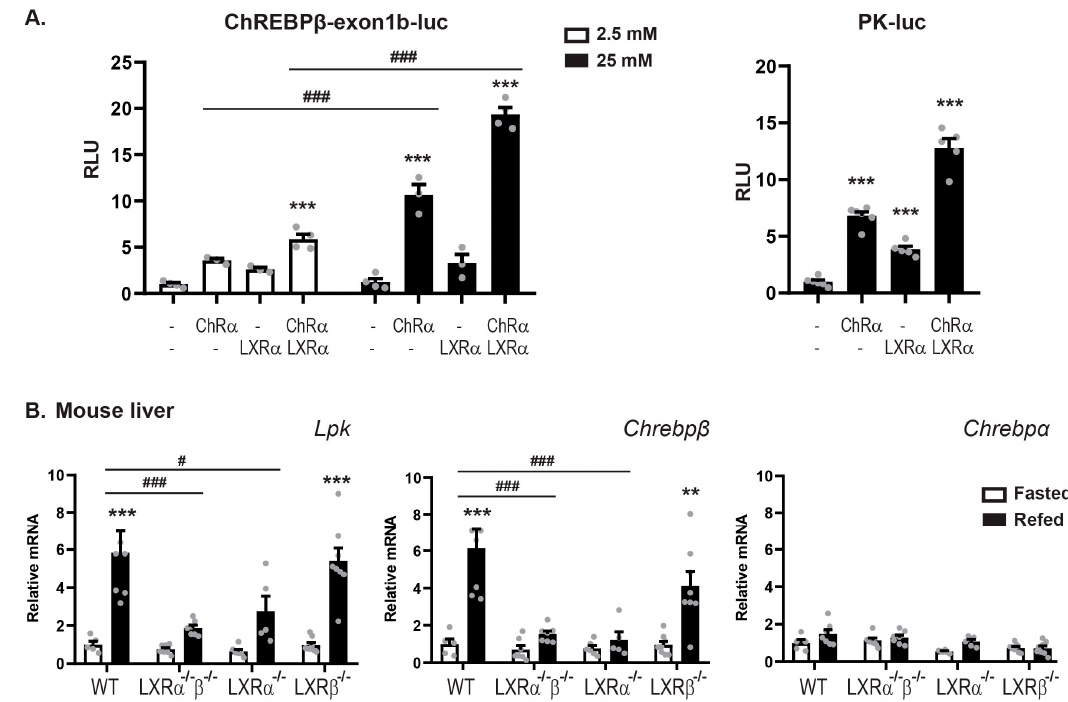
Figure 2. LXR α co-activates ChREBP specific target genes in vitro and in vivo . A. Huh7 cells cultured in 25 mM glucose were transfected with a Chrebp β ( n = 3) or Lpk -driven luciferase reporter ( n = 6) and plasmids expressing ChREBP α /Mlx γ , with or without LXR α /RXR α . The Renilla luciferase reporter pRL-CMV was used as internal control. Six hours post transfection, cells were treated with 2.5 mM or 25 mM glucose for 18 hours. Dual luciferase reporter assays were performed 24 hours post transfection. B. LXR αβ wild type (WT), LXR α -/- , LXR β -/- and LXR α -/- β -/- mice were fasted for 24 hours (white bars) or fasted for 24 hours and refed for 12 hours (black bars) ( n = 5–8 mice per group). Hepatic gene expression of Lpk ( Pklr ), Chrebp β and Chrebp α was analyzed by quantitative RT-PCR, normalized to Tbp and the control group set to 1. For the WT fasted group, Ct values were ≈ 28 for Chrebp α and 29 for Chrebp β . Data are presented as mean ± standard error of the mean (SEM). Significant differences are shown as * p < 0.05, ** p < 0.01, *** p < 0.001 compared to control within the same treatment and # p < 0.05, ## p < 0.01, ### p < 0.001 between indicated groups.